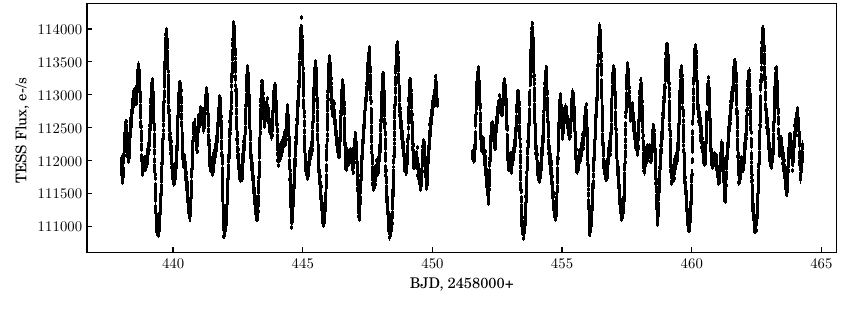
Figure 5. TESS photometry of